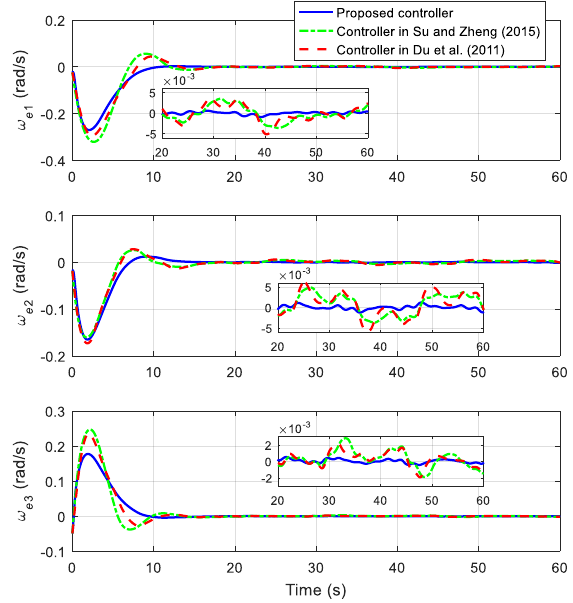
Figure 5. Profile of the angular velocity tracking errors